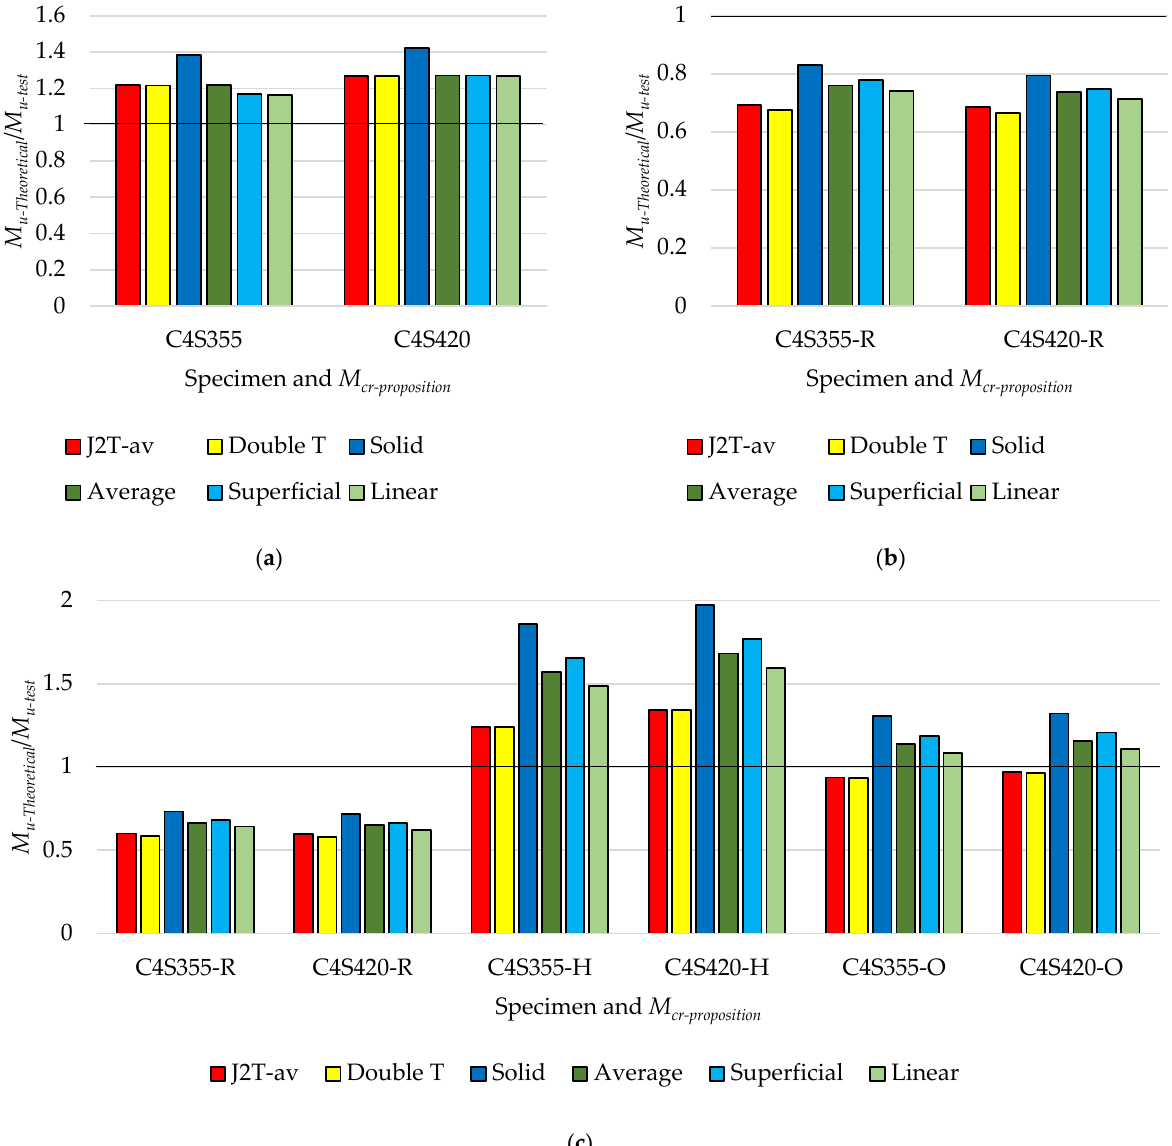
Figure 18. Accuracy obtained by the code’s adaptation approaches for composite cellular beams : ( a ) AS4100:1998 R2016 [105]; ( b ) ABNT NBR 8800: 2008 [108]; ( c ) EN 1994- 1-1: 2004 [107].